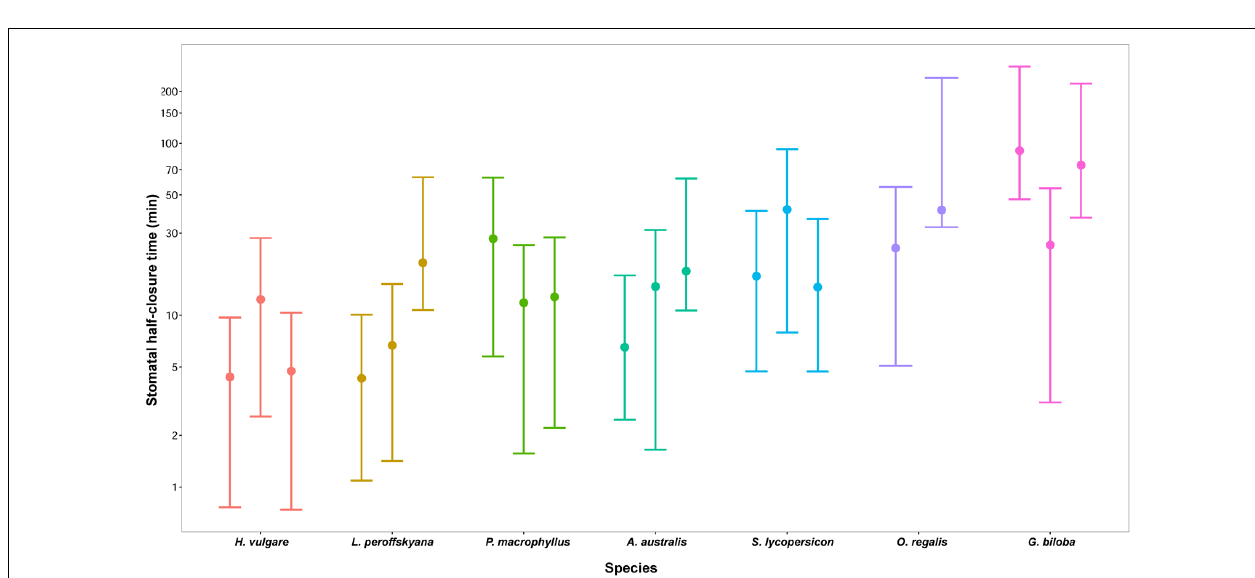
FIGURE 1 | Change in stomatal conductance ( g s ; mmol m − 2 s − 1 ) over time (minutes) in response to darkness in an evolutionary range of species grown at 380 ppm CO 2 and 20.9% O 2 fitted to an exponential decay curve. The fit was performed for each replicate of seven species. Species listed from fastest to slowest median half-closure time. (A) Hordeum vulgare ; (B) Lepidozamia peroffskyana ; (C) Podocarpus macrophyllus ; (D) Agathis australis ; (E) Solanum lycopersicon ; (F) Osmunda regalis ; (G) Ginkgo biloba . Light microscope images of stomata × 630.